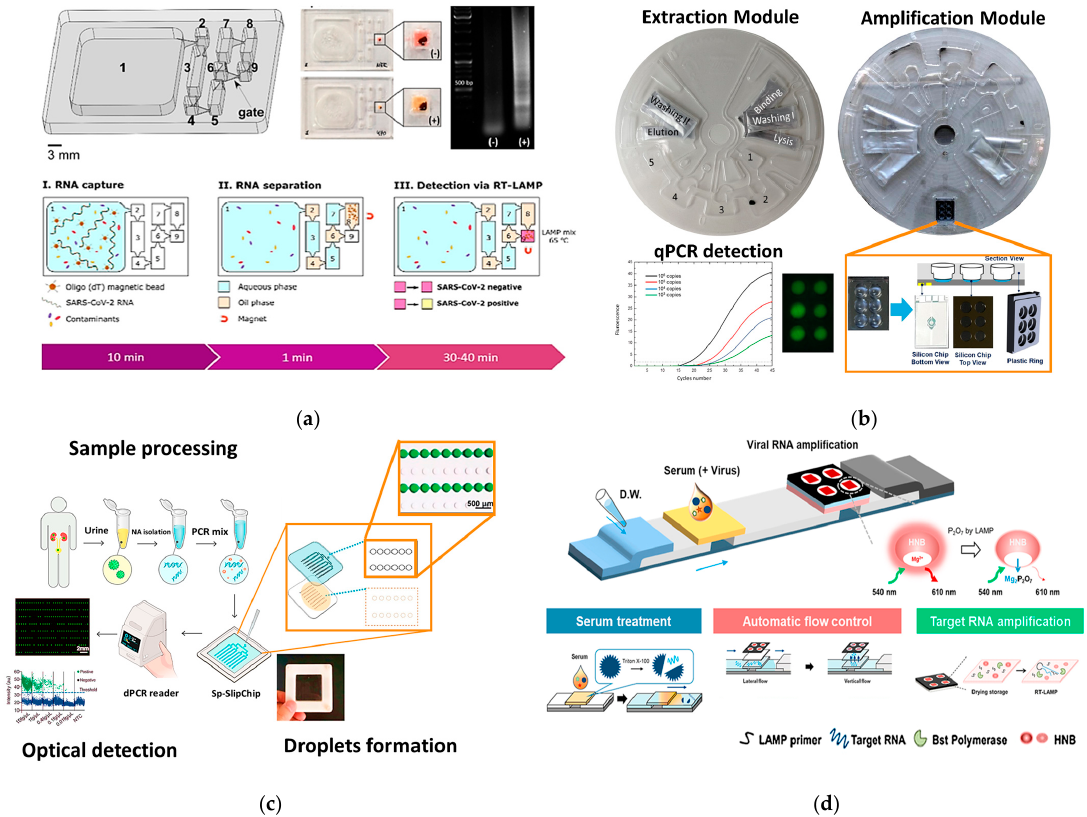
Figure 5. Schemes of the genetic PoC systems. ( a ) Fully integrated microfluidic PoC system for SARS-CoV-2 RNA analysis. Adapted with permission from [51] Copyright 2021, Elsevier. ( b ) Lab-on-disk for viral NA analysis. Adapted with permission from [52]. Copyright 2021, John Wiley & Sons—Books. ( c ) Sp-SlipChip microfluidic device and PI dPCR system for BKV DNA analysis in urine samples: detail of sample processing, droplet formation, and viral DNA detection by dPCR. Adapted with permission from [53]. Copyright 2021, Elsevier. ( d ) Paper-based integrated PoC for tropical virus diagnostics. Adapted with permission from [54]. Copyright 2021, Elsevier.